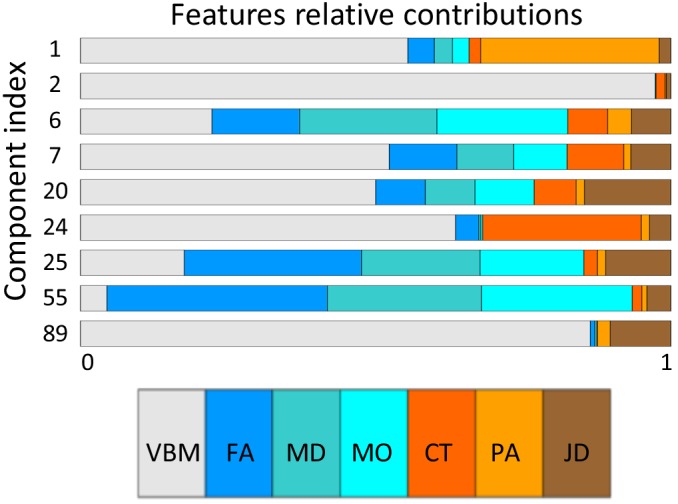
Relative contributions of each feature modality to the most relevant components.